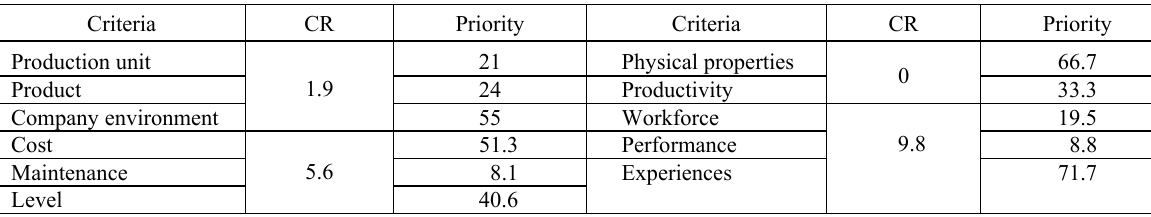
Table 4. Performance scores of main criteria